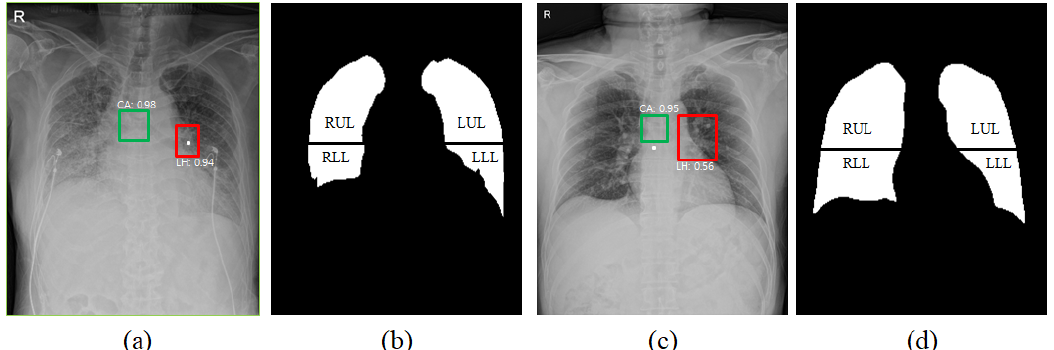
Figure 4. An example of detection results for the left hilum colored at red and carina colored at green and, dividing segmented lung mask into upper and lower lungs, i.e., RUR, LUR, RLR, and LLR with a reference point colored at while. ( a ) Detection results for the left hilum (confidence: 0.94) and the carina (0.98). ( b ) A center point of the detection box for the left hilum is used as the reference point to divide upper and lower lungs. ( c ) Detection results for the left hilum (0.56) and carina (0.95). ( d ) A location down to approximately 2 cm vertically from a center point of the detection box for the carina is used as the reference point to divide upper and lower